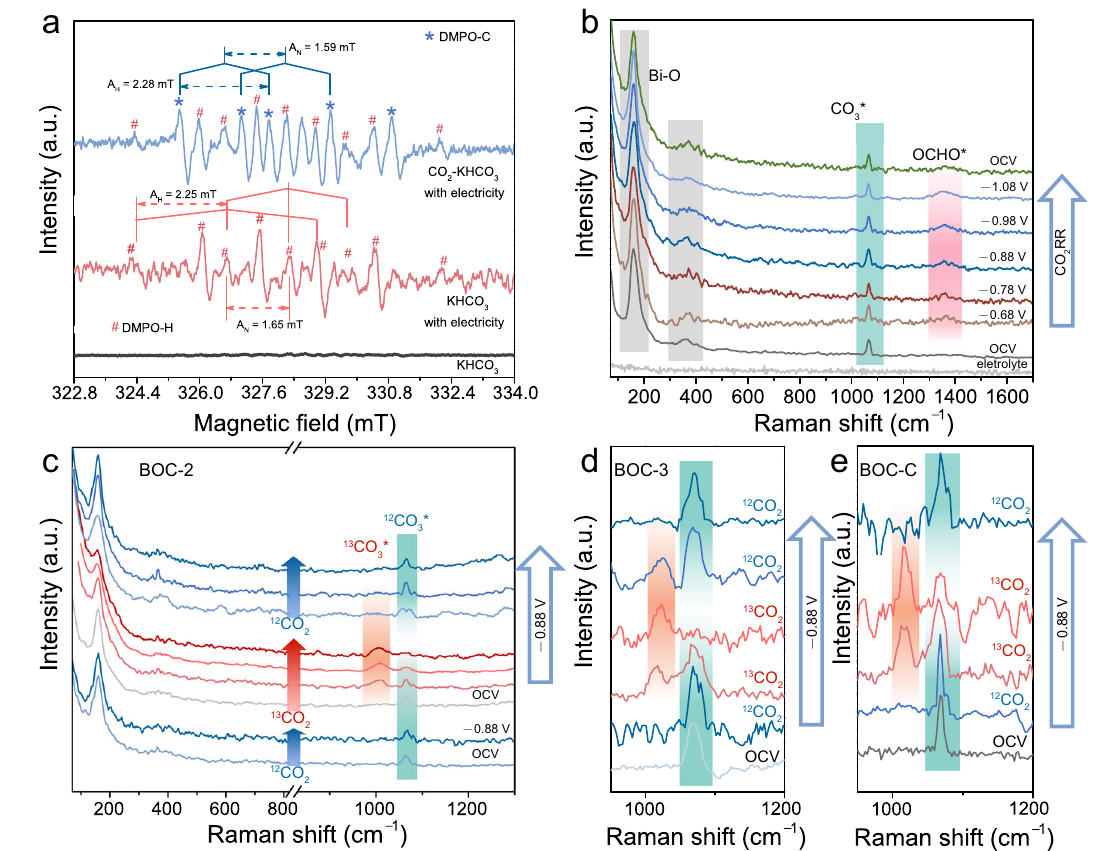
Fig.5|Theidenti fi cationoftheparticipationofCO 3 *inCO 2 RR.a EPRtrappingof carbonradicalsandhydrogenradicals. b InsituRamanspectroscopyforBOC-2ata